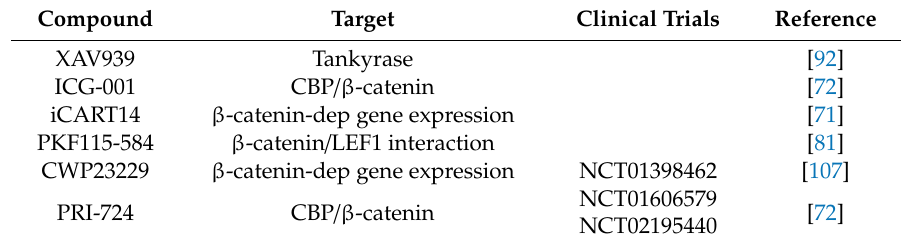
Table 1. Wnt / β -catenin inhibitors used in acute lymphoblastic leukemia (ALL) setting and in clinical